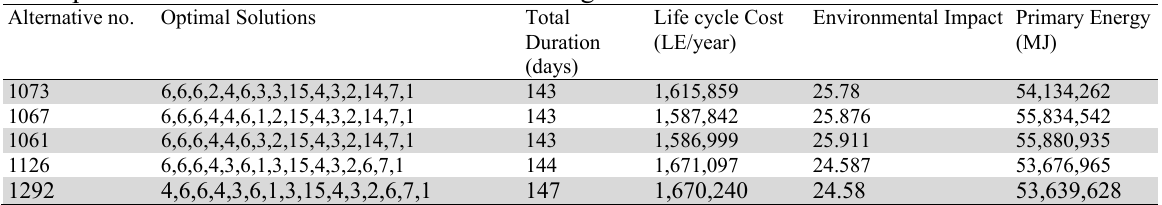
Description of alternatives with the first five rankings